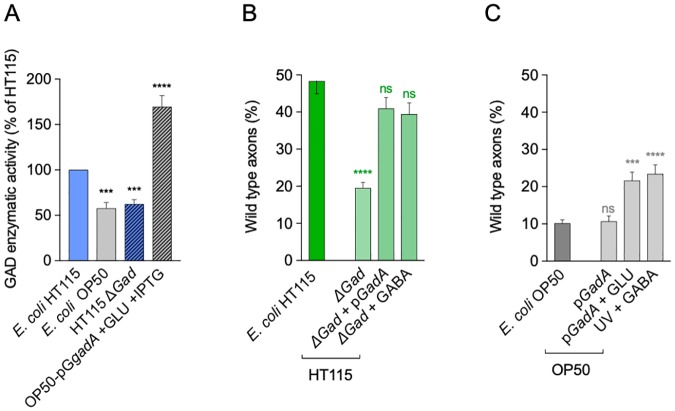
Bacterial GABA is crucial for neuroprotection.(A) Measurements of GAD enzyme activity normalized as a percentage of HT115 GAD activity in wild-type, mutant, and transformed bacterial strains. (B and C) Percentage of wild-type axons in wild-type and Δgad mutant HT115 strain (B) and wild-type OP50 strain (C) supplemented with GABA and genetically transformed with the pGgadA plasmid. ****P < 0.0001, ***P < 0.001, ns. The underlying numerical data and statistical analysis for each figure panel can be found in S1 and S2 Datasets, respectively. GABA, γ-aminobutyric acid; GAD, glutamate decarboxylase; gad, glutamate decarboxylase enzyme gene; ns, not significant.